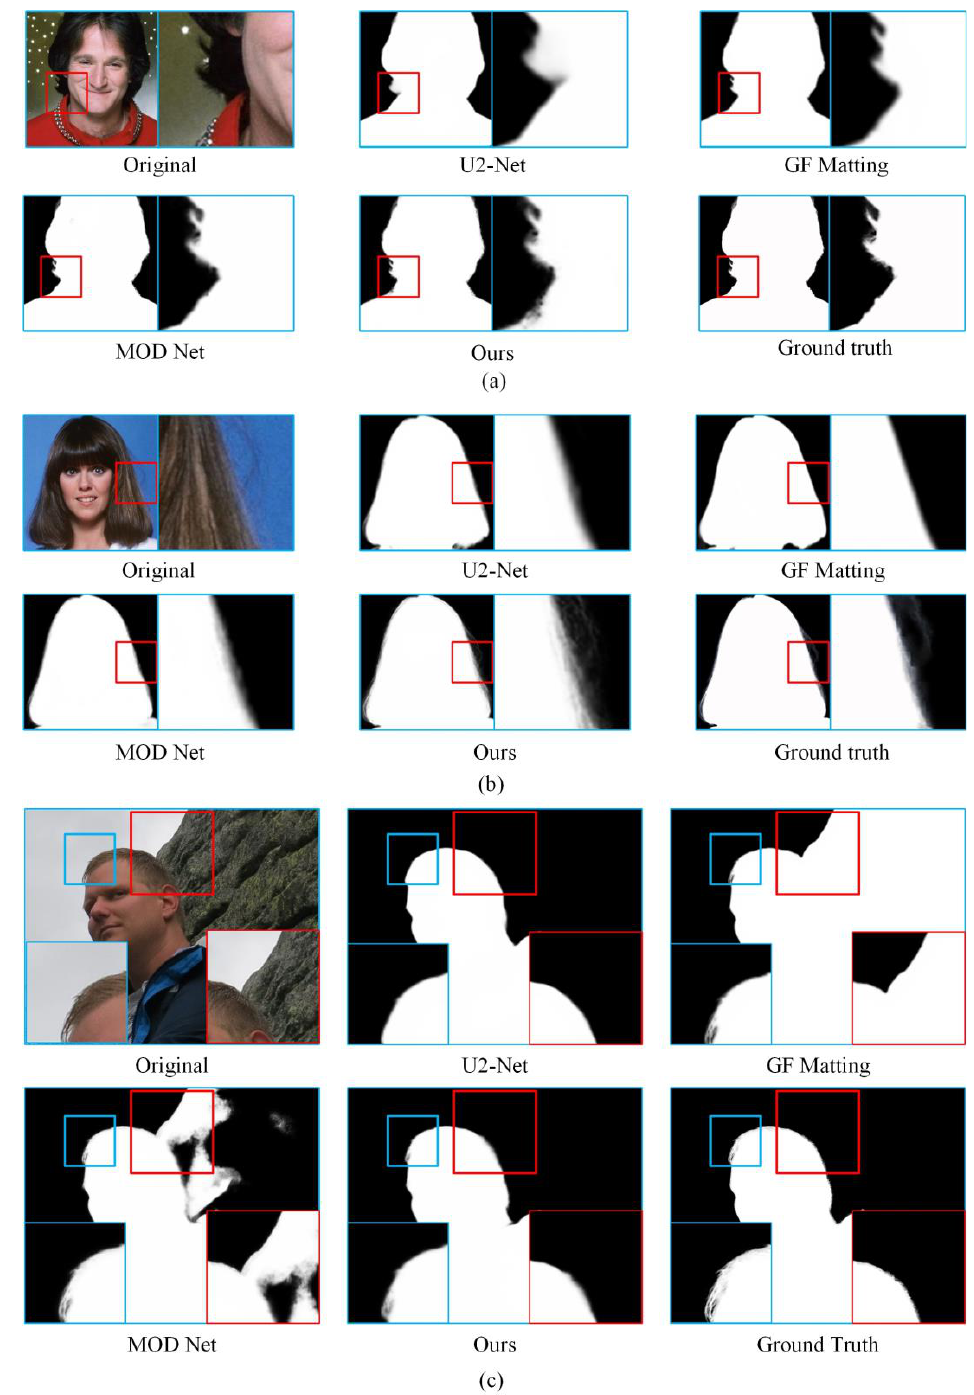
Figure 8. Experimental results of the self-built matting test set: ( a ) Chart 28 in the dataset; ( b ) Chart 67 in the dataset; ( c ) Chart 50 in the dataset. 67 in the dataset; ( c ) Chart 50 in the